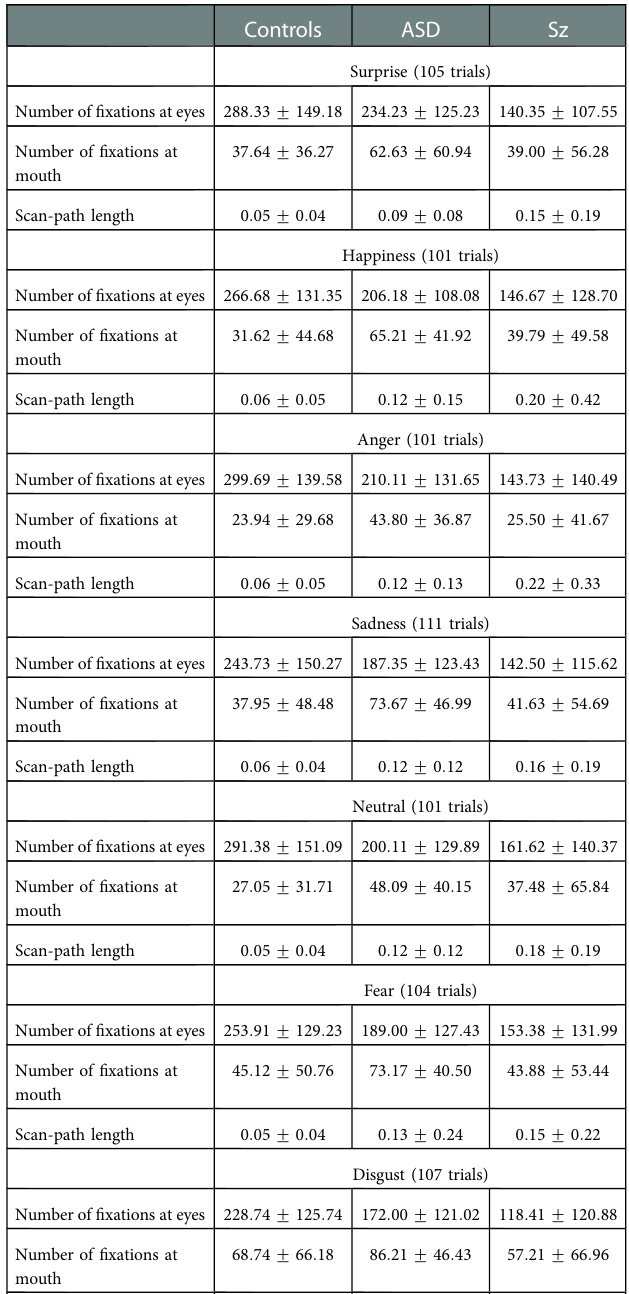
TABLE 4 Statistical analysis of controls and ASD children participants ( mean + SD ).